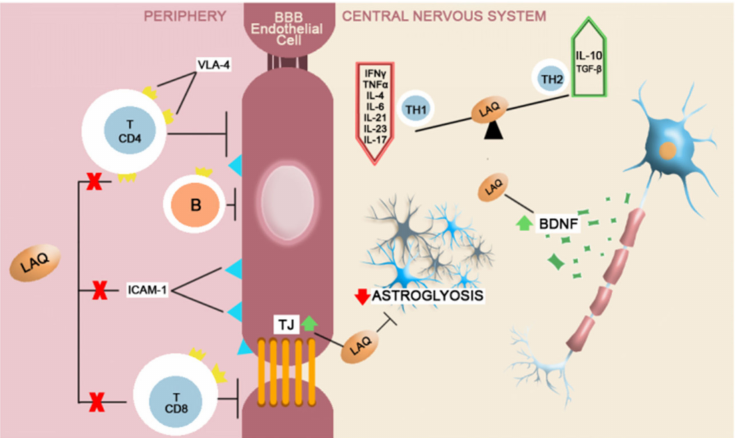
Figure 3. A brief schematic representation of Laquinimod’s mechanism of action. In the peripheral compartment, Laquinimod inhibits the lymphocytic differentiation for CD4+ and CD8+ Th cells, limits the B cells passage and the lymphocytic endothelial adhesion by down-regulating VLA-4 and ICAM-1 [97,101–103]. The neuroprotective effects of laquinimod are dependent on BDNF up- modulation with secondary reduced axonal loss. It also reduces astroglyosis and oligodendrocyte apoptosis and reduces the expression of proinflammatory Th1 cytokines, while augmenting the T2 anti-inflammatory response